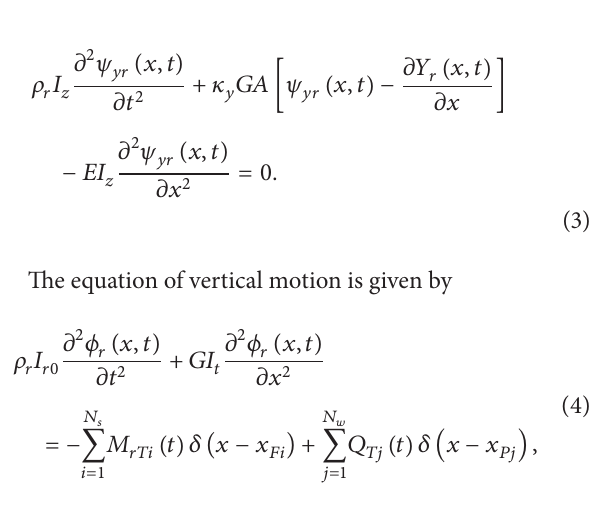
Figure 4: Sketch of the forces acting on a